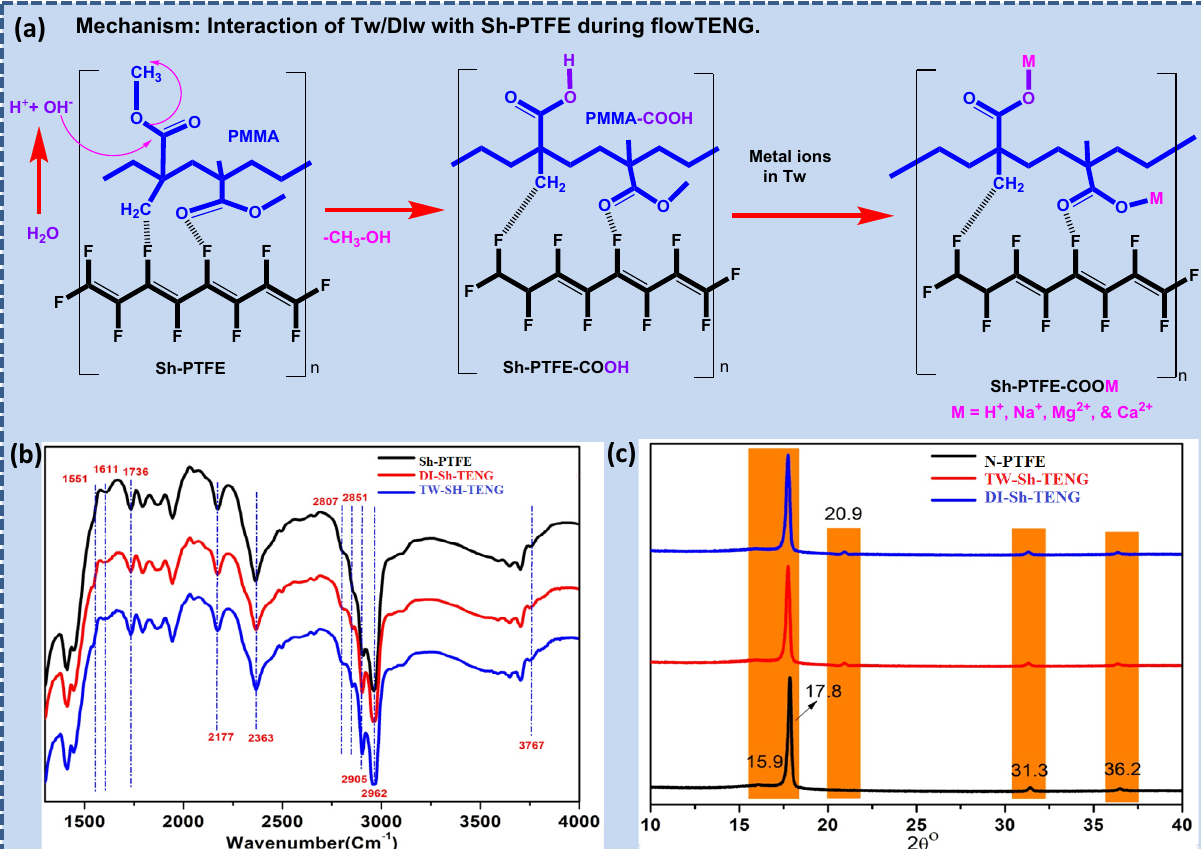
Figure 5. Schematic representation of mechanism of ( a ) Sh-PTFE with water molecules and nucleophilic elimination of CH 3 OH; ( b ) FT-IR; and ( c ) XRD spectra of N-PTFE and